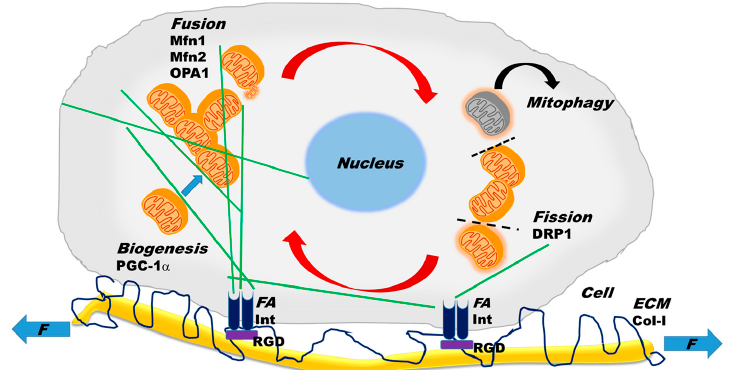
Figure 2. Intracellular and extracellular processes contributing to mitochondrial structure and function. Intracellular mitochondrial (orange) dynamics include the processes of fusion, fission, mitophagy, and biogenesis. See text for explanation for how the various molecules such as OPA1, Mfn1, Mfn2, and DRP1 govern these processes. The grey mitochondrion is damaged and degraded by mitophagy. Green lines represent microtubules, along which small mitochondrial clusters can travel with the aid of motor proteins. The dashed line represents the site of fission and the red arrows indicate the cyclic nature of fission and fusion. Note that biogenesis increases mitochondrial volume and is regulated by the peroxisome proliferator-activated receptor γ coactivator (PGC-1 α ). Cells are connected to the ECM (extracellular matrix) and exposed to external mechanical forces (F) at focal adhesions (FA), involving integrin receptors (Int) on the cell surface and Arg-Gly-Asp (RGD) binding sites on collagens fibers (Col-I). The cytoskeleton is linked to FAs and therefore mechanical forces from the ECM are transmitted to the mitochondria.